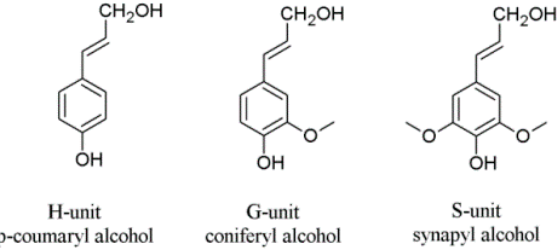
Figure 1. Lignin units H, G, and S derived from corresponding cinnamoyl alcohols.